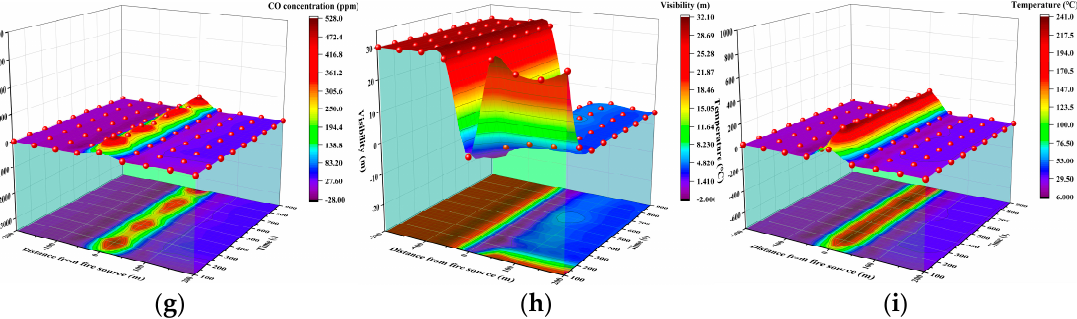
Figure 16. Simulation results of fi re characteristics at 3.6 m/s ventilation velocity: ( a − c ): 30 MW; ( d − f ): 20 MW; ( g − i ): 5 MW.